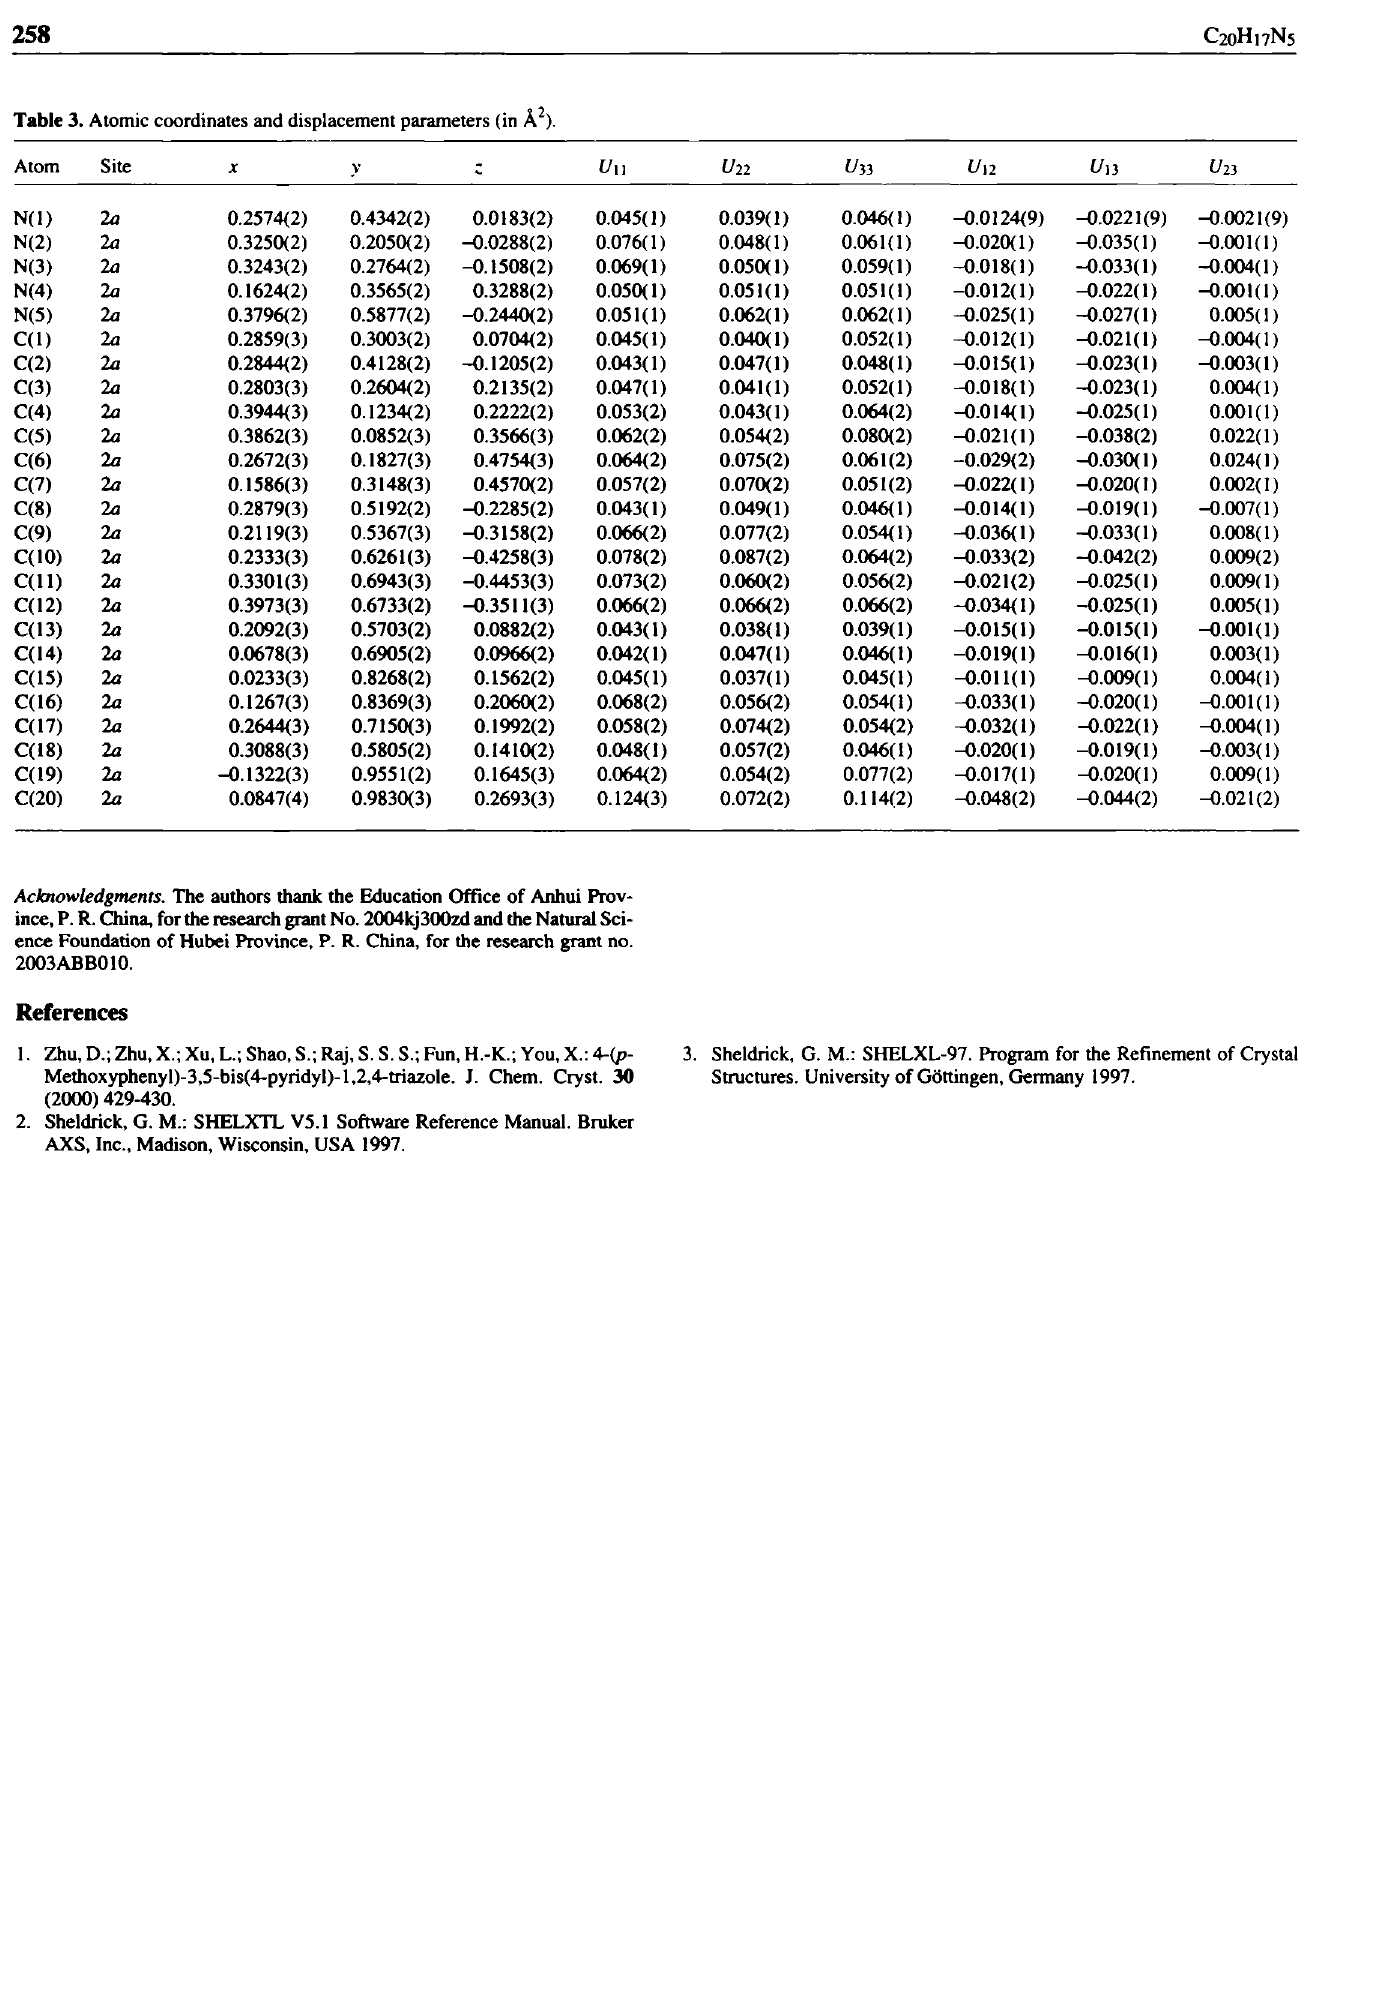
Table 3. Atomic coordinates and displacement parameters (in Â 2